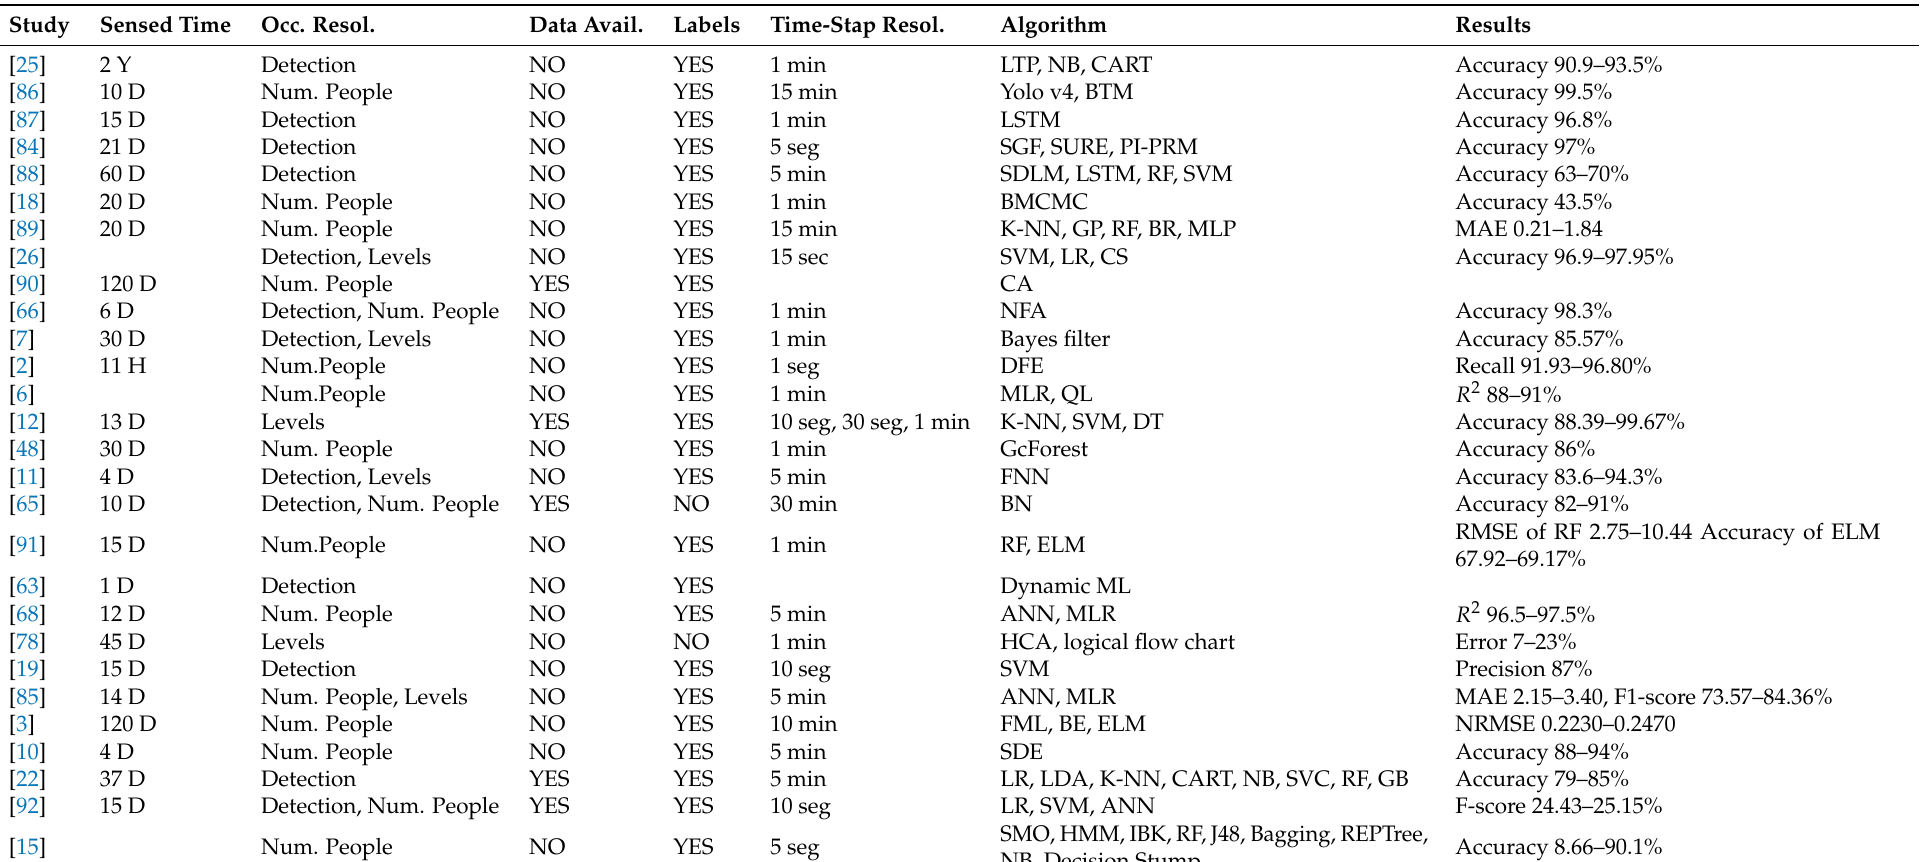
Table A1. Datasets characteristics and algorithms